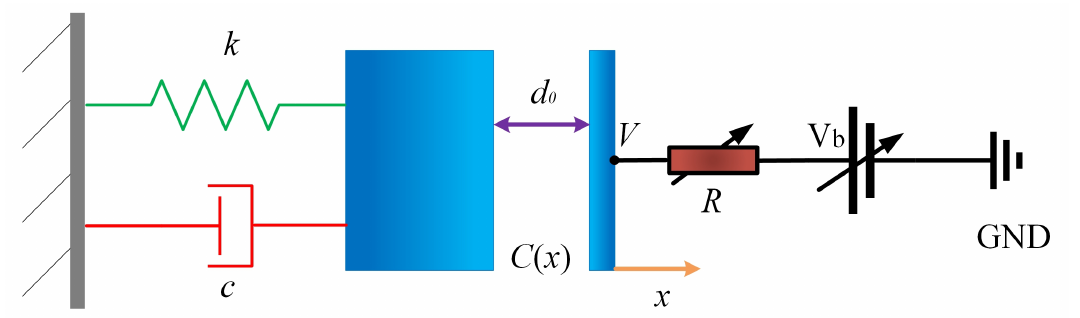
Figure 1. Schematic of the damping tuning based on the resistance heat dissipation.